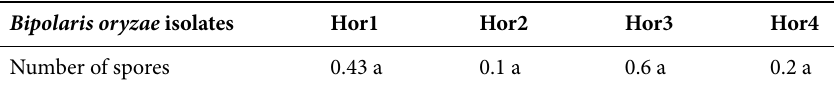
Table 5 Sporulation of Bipolaris oryzae on Typha latifolia leaves aer inoculation with spore suspensions (×10 5 spores/cm 2 ).